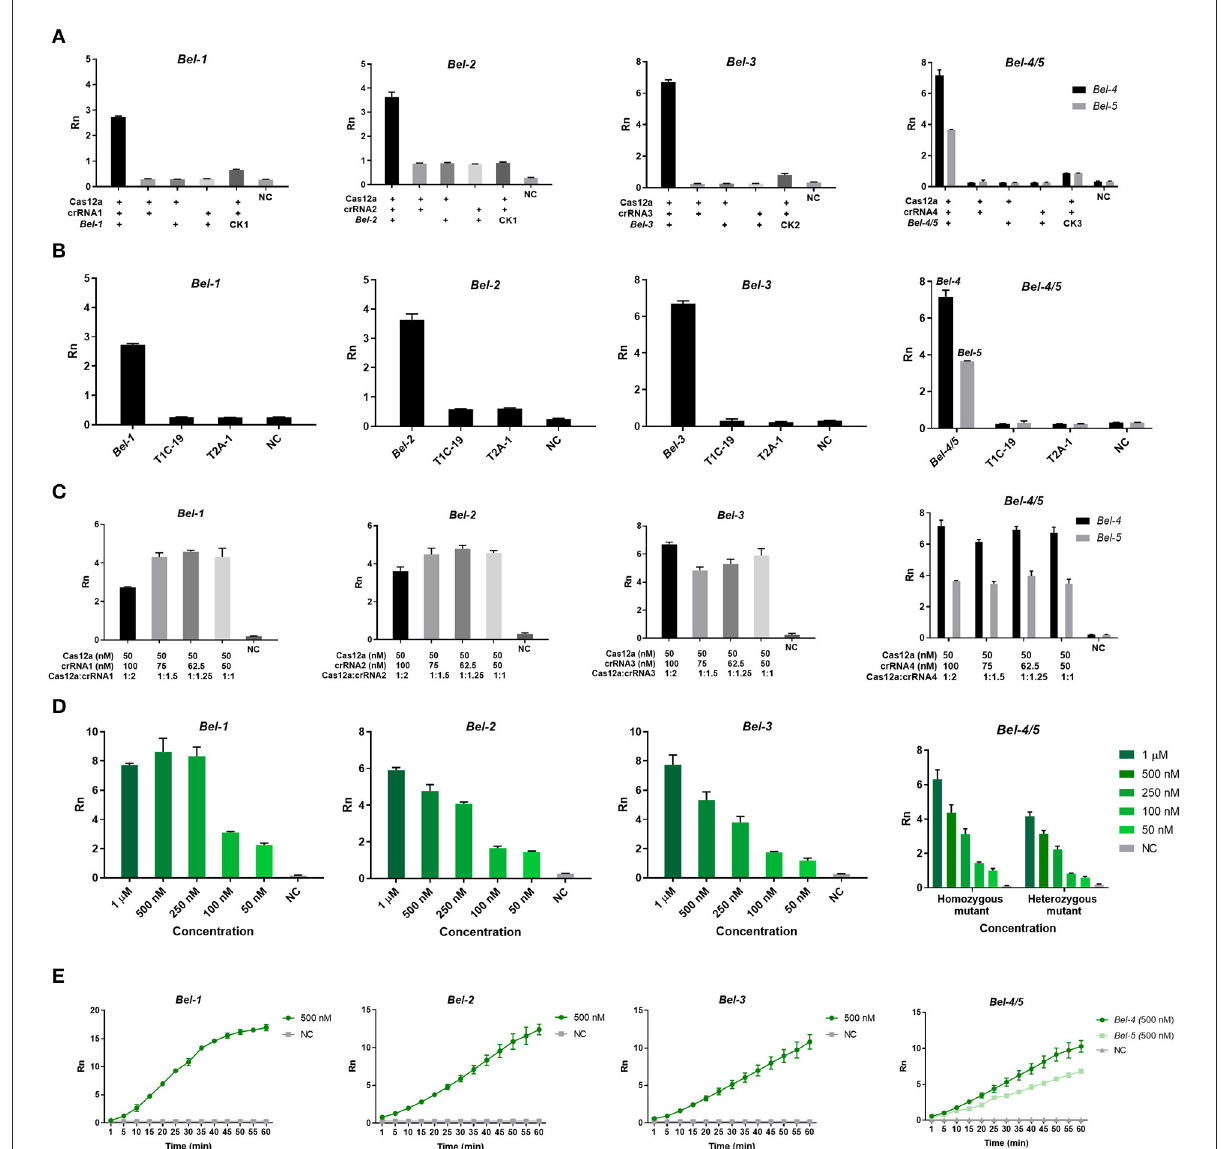
FIGURE3 Optimization of the Cas12aFVD biosensing platform. Signals detected by the 7500 Real-Time PCR System. (A) Feasibility of the Cas12aFVD biosensing platform for nucleic acid detection. (B) Cas12a/CRISPR RNA (crRNA) detection specificity analysis. (C) Optimization of the molar ratio of Cas12a/crRNA. (D) Optimization of the concentration of ssDNA probe 1. (E) Cas12a/crRNA cleavage time. NC, negative control. n = 3, error bars show the mean ±